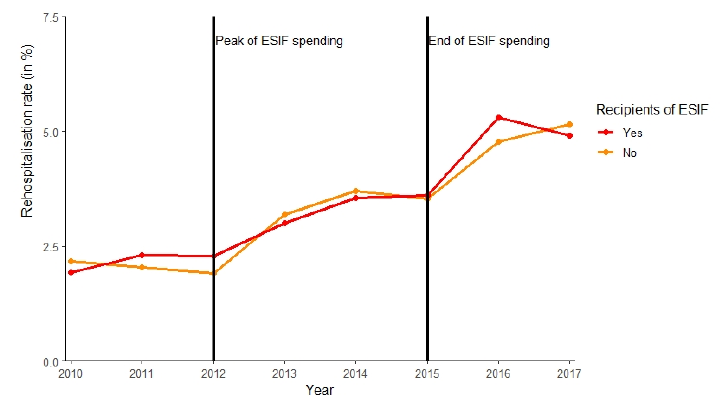
Figure 4: Development of the readmission rate in Slovak hospitals in 2010-2017 econ controls represent the hospital and district controls, respectively 14